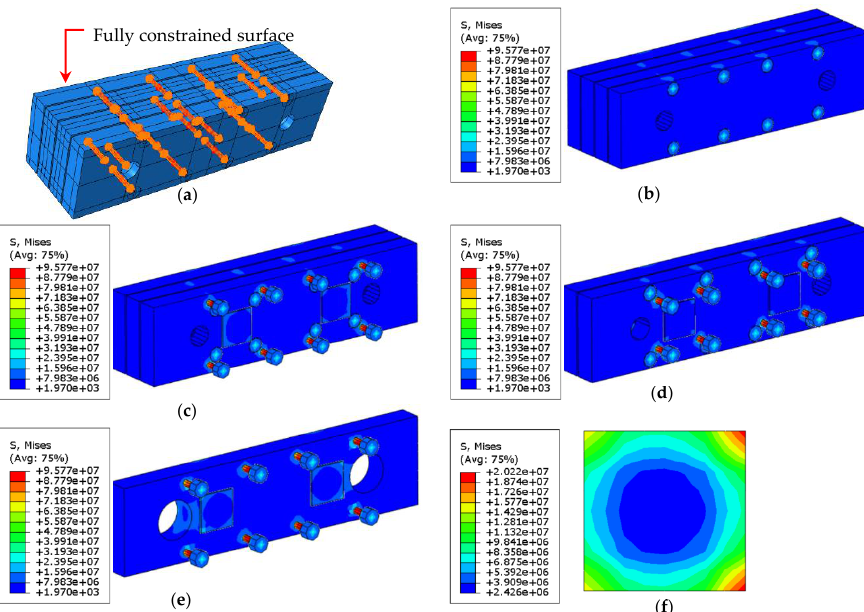
Figure 12. Simulation to investigate the stress field of the piezoelectric sensors and the setup by applying equivalent bolt loads to each screw: ( a ) the boundary conditions and the loads applied on the screws; the stress distribution (Pa) on ( b ) the first layer, ( c ) the second layer and Z -axis sensors, ( d ) the third layer and Y -axis sensors, ( e ) the fourth layer and X -axis sensors, and ( f ) one of the X -axis